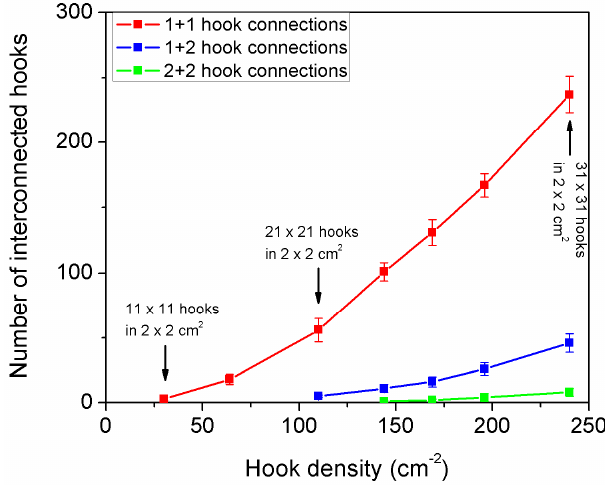
Figure 8. Diagram of the calculated number of interlocked hooks versus hook density.